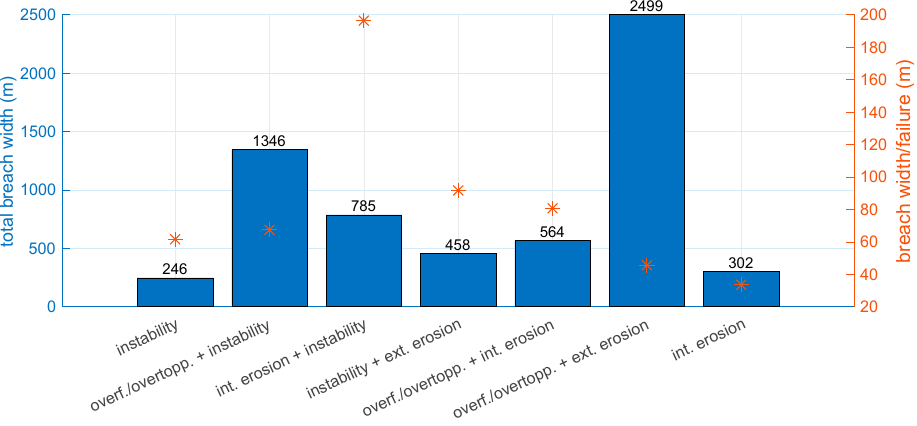
Figure 12. Breach width analysis per failure mechanism occurred during the flooding event in Germany, 2002 and 2013.